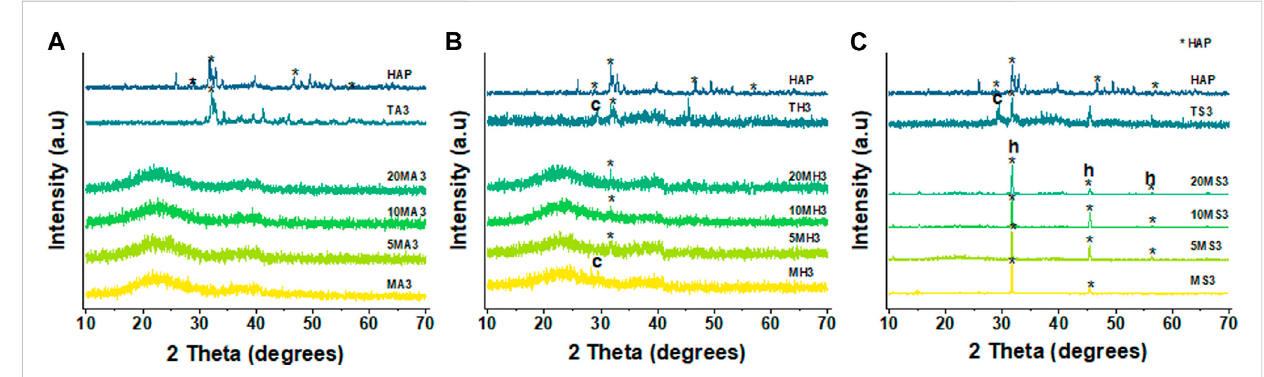
FIGURE 7 XRD patterns of all the particles following immersion for 3 days in AS (A) , HBSS (B) and SBF (C) where * refers to the HAP, h represents halite, and c refers to